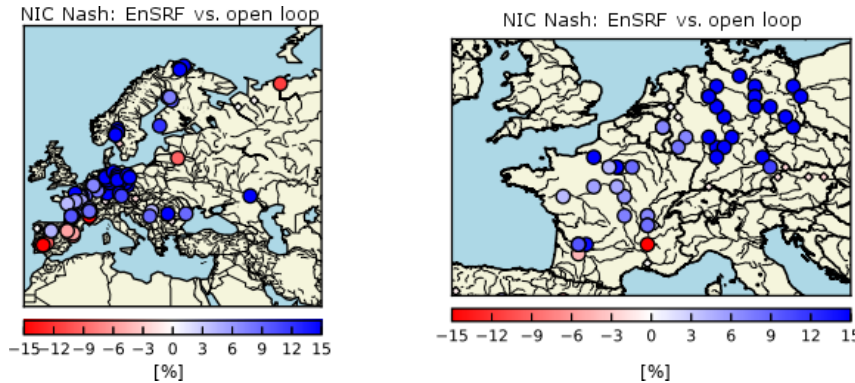
Figure 14. Normalized information contribution (NIC) index assessing the improvement of Nash–Sutcliffe efficiency indices for EnSRF river discharge estimates compared to open-loop counterparts. Blue circles denote a positive impact of DA; red circles denote a negative impact; and small diamonds denote a neutral